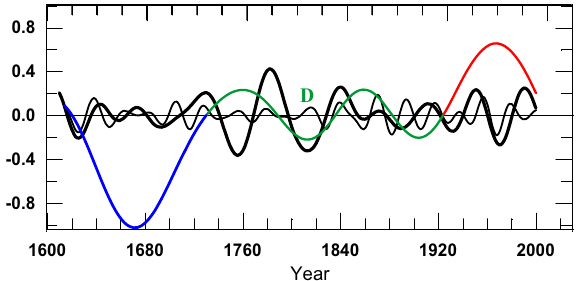
Fig. 6. The three components in which the long-term variations in R max and aa min can be decomposed are shown here for R max . These are: the secular cycle (the line with the same sequence of colours as in Fig. 4), the semi-secular and the bi-decadal oscillations (thick and thin lines,